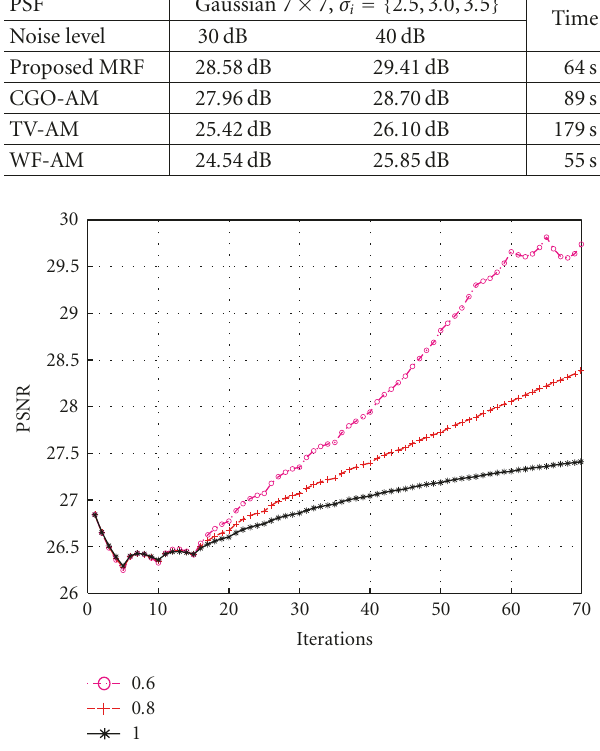
Table 1: Comparison of di ff erent restoration algorithms. PSF